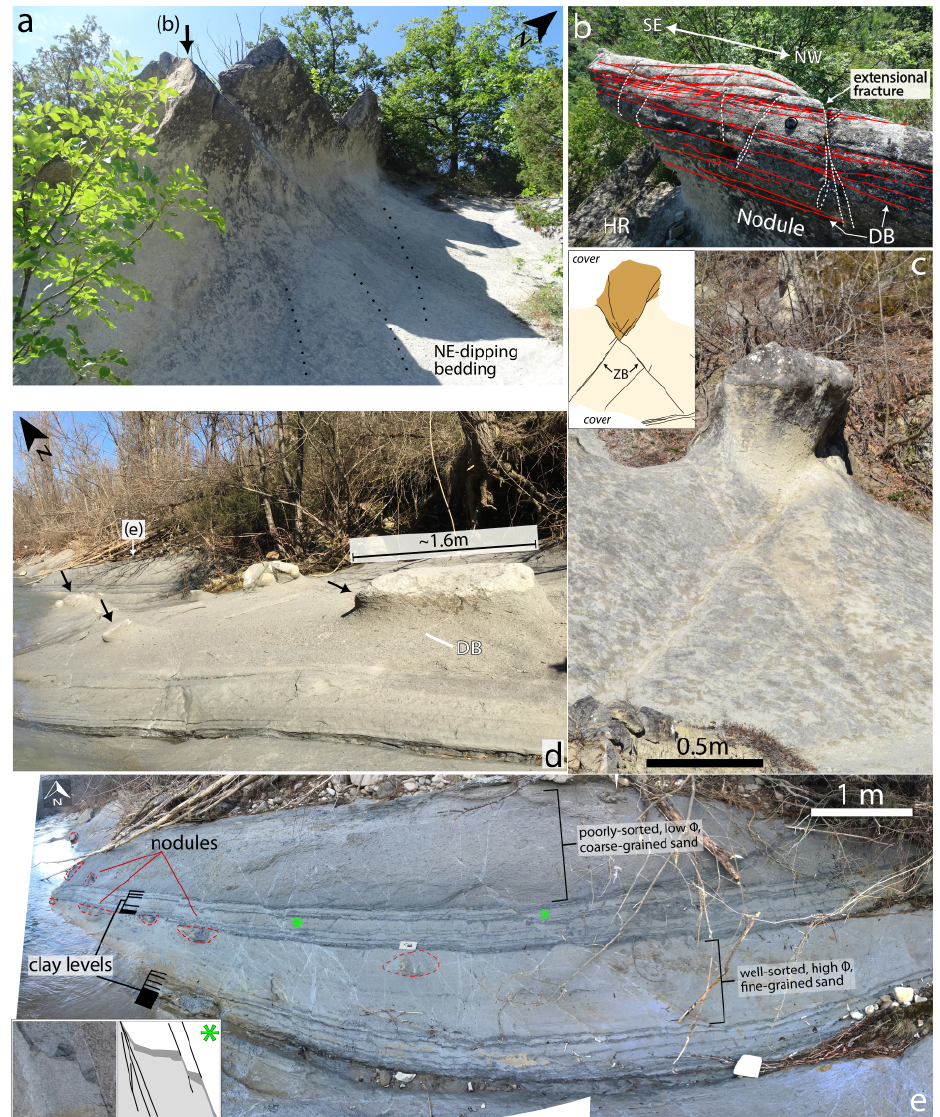
Figure 5. (a–c) DB-parallel- and (d–e) bedding-parallel nodules. (a) Decametric-scale continuous nodule with a tabular geometry located along a zone of bands (ZB). NE-dipping layering is shown with dotted lines. The photo is about 10m in depth. (b) Close-up of (a) from a map view. The lens cover is 5.5cm in diameter. (a, b) Late-opening fractures cut through the assemblage “DBs – nodule” and they do not propagate into the poorly consolidated host rock. (c) Isolated nodules placed in between and confined by ZB. (d, e) The bedding is emphasized mostly by clay and silt horizons, sporadic well-defined thin levels of gravel, and the alignment of bedding-parallel nodules. (d) Black arrows point to multiple but laterally discontinuous bedding-parallel nodules. Here, a single DB (white line) crosses a bedding-parallel nodule without causing any offset. The position of (d) is indicated in Fig. 3. (e) Photomosaic showing a series of laterally discontinuous nodules just below, above, or in between several continuous impermeable clay-rich levels. The deformation pattern changes depending on the host rock properties (e.g., sorting degree, porosity φ , grain size; see Supplement S1 for details). Cataclastic deformation is accompanied by clay smear (see inset) whereby DBs cut thin dark-colored clay